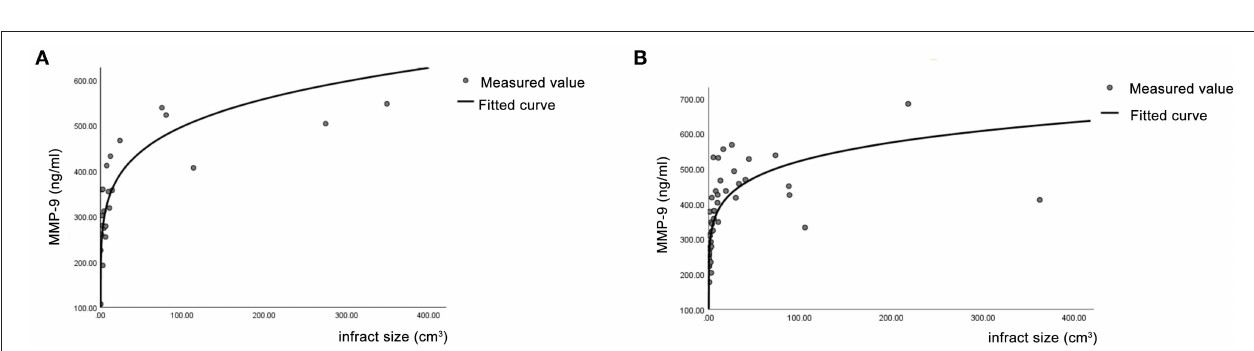
FIGURE 2 | Matrix metalloproteinase-9 (MMP-9) level on the first, third, and sixth day of treatment (A) and the change in MMP-9 level between the two groups (B) .